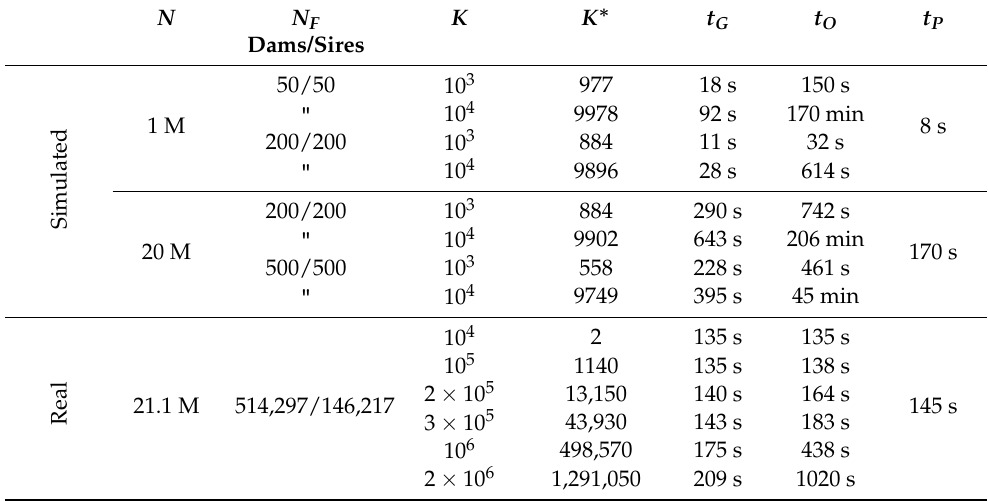
Table 1. Experimental results for the processed pedigrees. N denotes the size of the pedigree; N F denotes the number of founder individuals, separately for the maternal and paternal lines; K and K ∗ denote the submitted and the actual number of selected individuals, respectively; t G , t O and t P denote times measured for the greedy processing, optimal processing, and the preprocessing, respectively. N N F K K